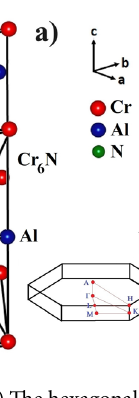
Figure 4. ( a ) The hexagonal crystal structure of Cr 2 AlN, where blocks of Cr–N (formed by edge-shared Cr 6 N octahedra) are sandwiched with Al atomic sheets. ( b ) The hexagonal Brillouin zone for Cr 2